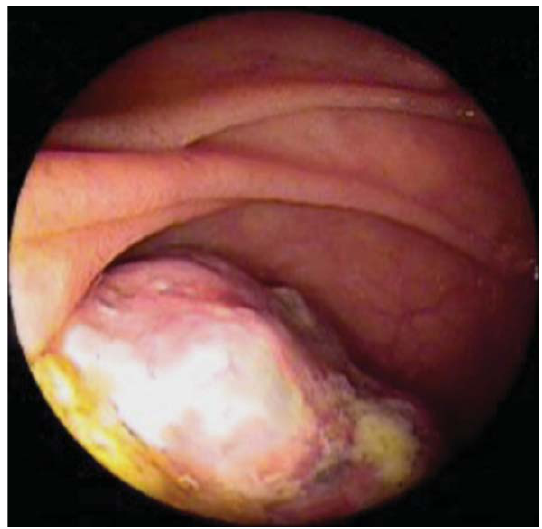
Figure 1. Vegetative lesion on the fourth portion of the duodenum